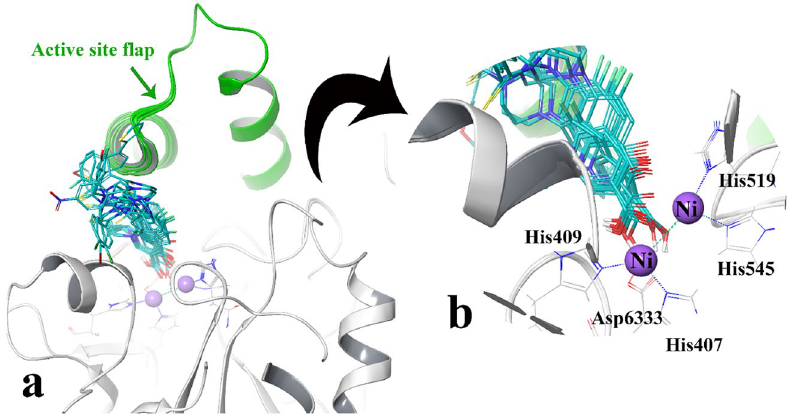
Figure 4. Representation of the compounds docking poses over the active site ( a ) close-up illustration of ciprofloxacin nucleuses relative to the binuclear center ( b) , the active site flap (colored in green color).